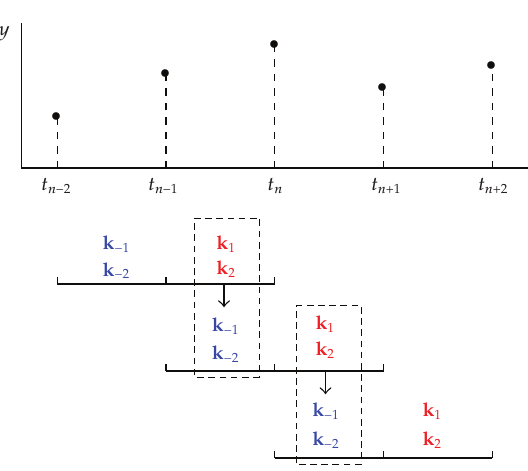
Figure 1: The central idea of the ARK3 method is illustrated here. Approximating the solution y n (cid:7) 1 at t n (cid:7) 1 requires 2 function evaluations k 1 and k 2 (cid:4) shown in red (cid:5) and two reused values k − 1 and k − 2 (cid:4) shown in blue (cid:5) from the previous steps k 1 and k 2 . This process repeats for the next step (cid:4) approximating the solution at t n (cid:7) 2 (cid:5)